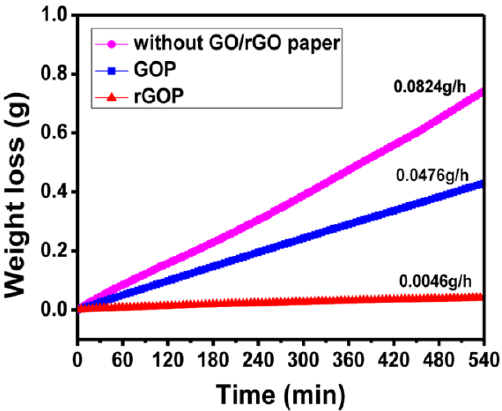
Figure 15. Wettability of the GO paper and RGO paper and its effect on the actuator operation time. Reproduced from [37] with permission from American Chemical Society. Copyright 2014.